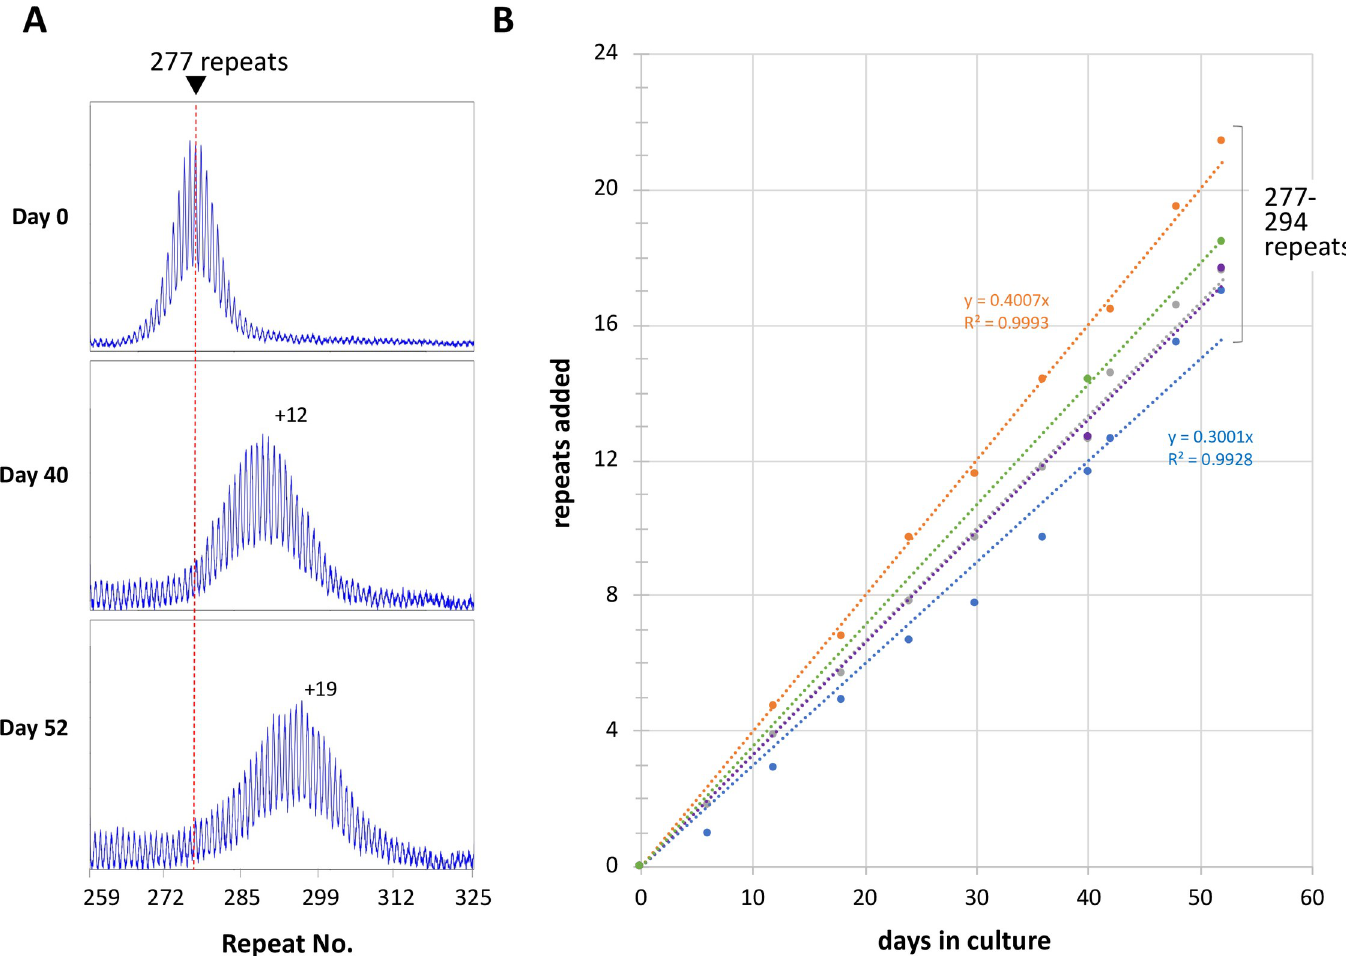
Fig 1. Repeat expansion in mESCs with ~280 repeats during time in culture. A) PCR profiles of a cell line WT for Mlh3 , Pms2 and Pms1 with a starting allele of 277 repeats after 0, 40 and 52 days in culture. The red dotted line indicates the major allele present at day 0. B) Repeats added as a function of time for the cell line shown in panel A together with four additional lines with initial repeat numbers of 286–294. Only the trendline equation and R 2 values for the fastest and slowest expanding lines are shown.